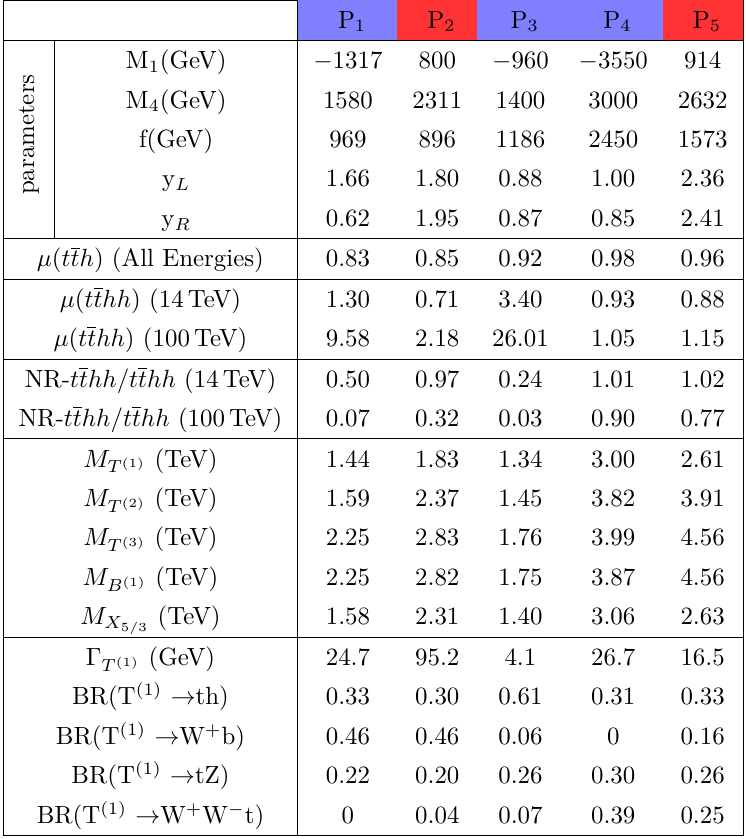
Table 1 . Properties of selected example points in the low scale MCHM 5 . Red and blue column headings indicate points belonging to Region I and II